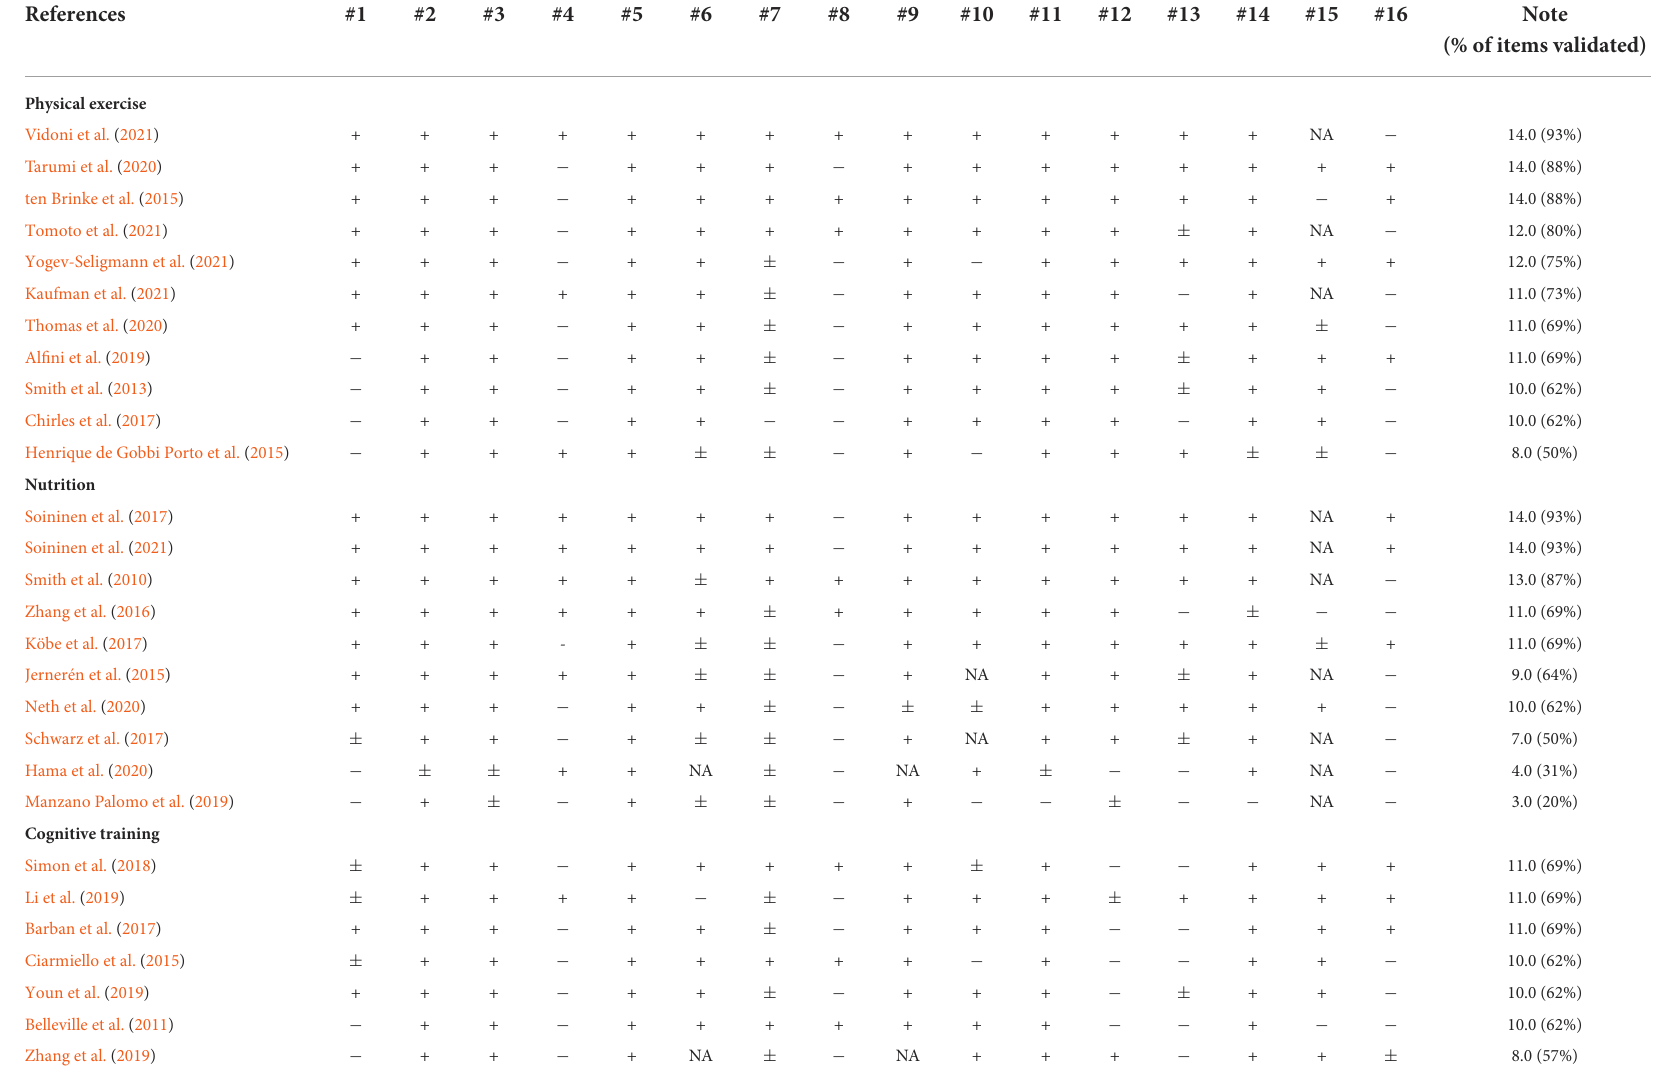
TABLE 2 Assessment of studies’ methodology (refer to Table 1 for the description of the notation